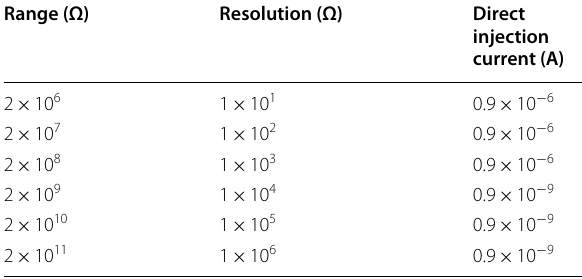
Table 2 Accuracy specifications for resistance measurement